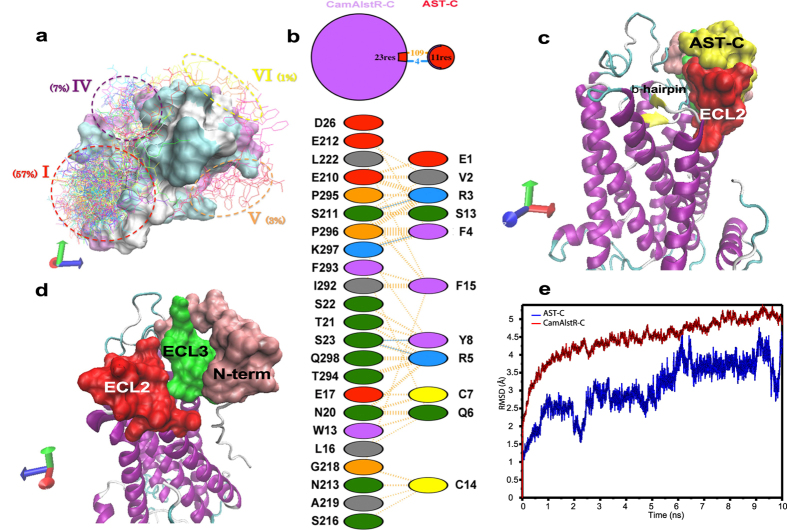
Constituents of putative binding pocket.(a) Clustering of different docking poses (n = 100) of AST-C on CamAlstR-C showed six different regions four of which were on the extracellular region. (b) Interacting residues of the most probable binding pocket were obtained from LIGPLOT. 3D structure of the binding pocket (c) with and (d) without the ligand was composed of ECL2 (red), ECL3 (green) and N-terminal loops (pink). (e) Molecular dynamic simulations for 10 ns for the ligand and the receptor showed that the RMSD reached a maximum of 4.5 and 5.5 Å, respectively.